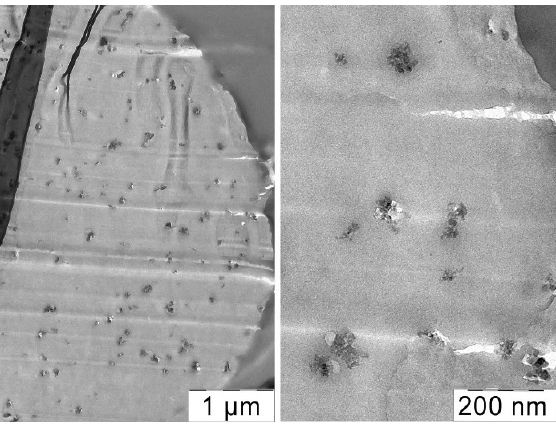
Figure 15. TEM images of PAN fiber cross-section containing 3% silica (at the polymer weight).